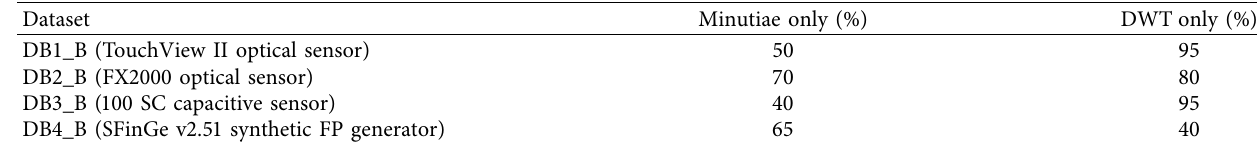
Table 5: Performance of separate features (minutiae and DWT).